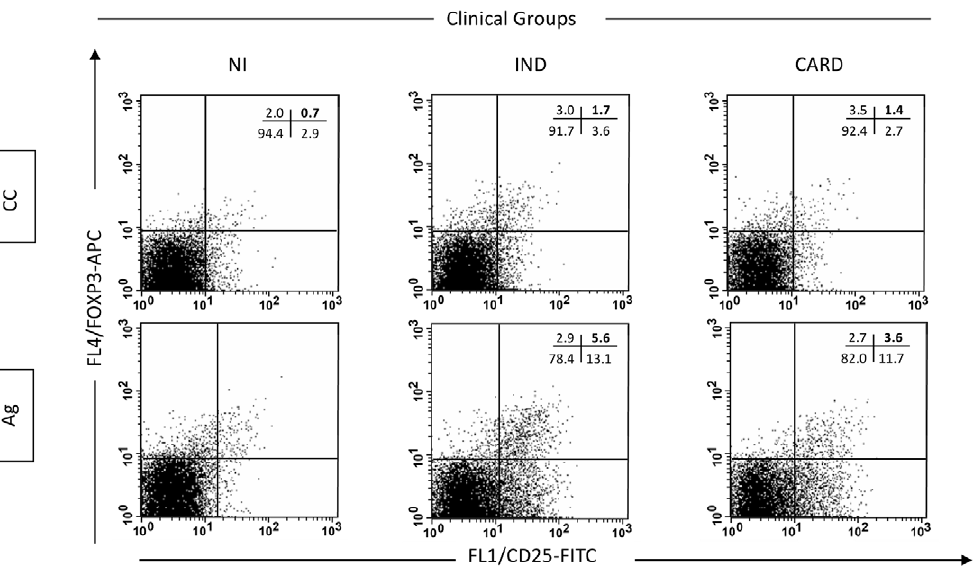
Figure 3. Analysis of Foxp3 + CD25 High CD4 + regulatory T cells in the peripheral blood from chagasic patients. Representative dot plots illustrate that the increased levels of regulatory T cells observed in T. cruzi antigens-stimulated cultures from IND tend to be higher than that observed in CARD, and also reflect an increased level of Foxp3 + CD25 + cells in the IND group (bottom graphs). Quadrant statistics were used for data analysis, and the results are expressed as the percentage of positive cells within the CD25 + CD4 + selected lymphocytes. Reproduced and adapted from [20].